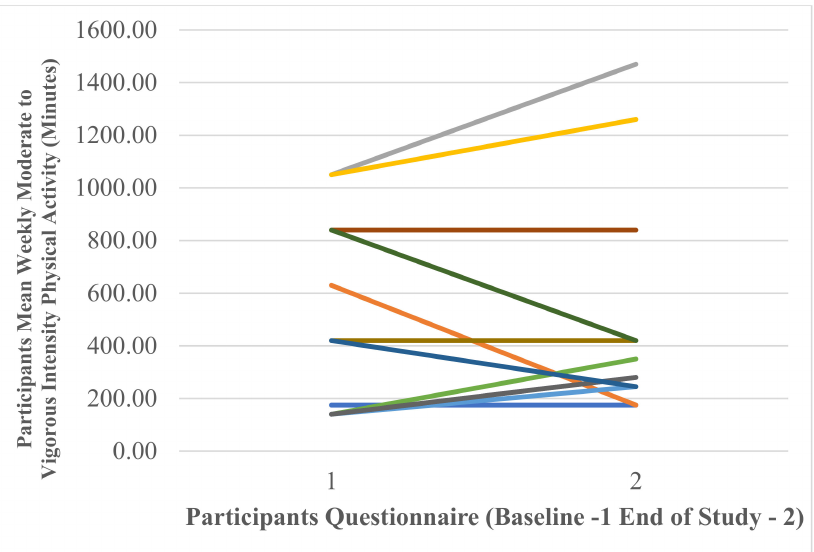
Figure 11. Individual participants’ self-reported mean weekly minutes of moderate- to vigorous-intensity physical activity at baseline and end of study (each coloured line represents one of the 12